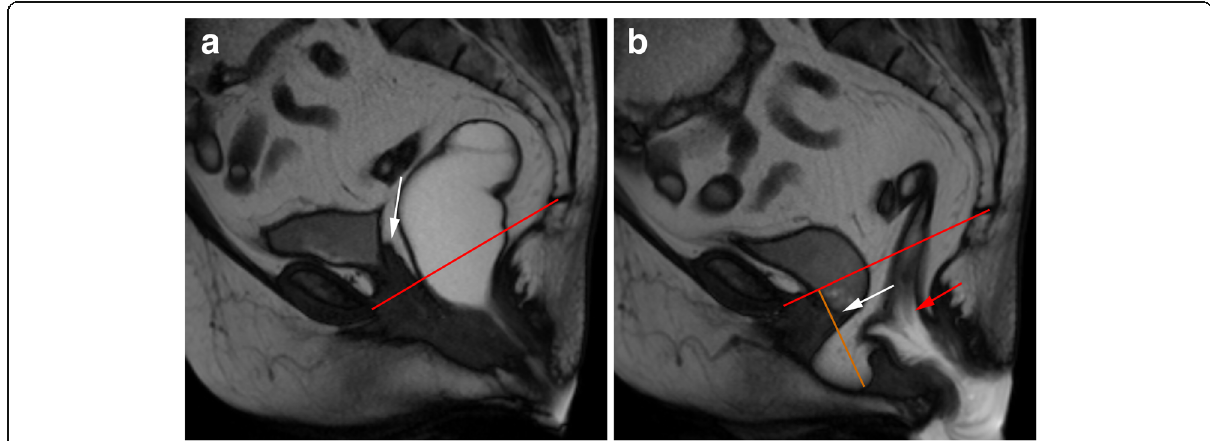
Fig. 15 Peritoneocele with vaginal vault prolapse and rectal intussusception. ( a , b ) Sagittal midline TrueFISP images at rest ( a ) and during defecation ( b ) of a patient previously submitted to hysterectomy, showing a peritoneocele, where adipose peritoneal folds insinuate to the rectovaginal septum. It is associated with a prolapse of the vaginal vault, with the vaginal apex (white arrows) below the PCL (red line) during the evacuation. An apparent rectal invagination is also present (red arrow). Orange line : extent of the peritoneocele